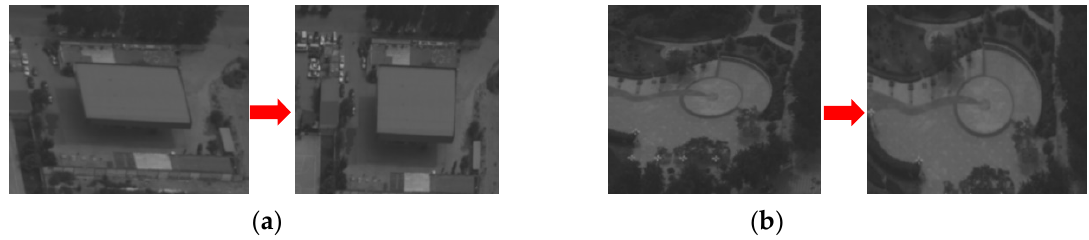
Figure 9. Partial perspective rectification: ( a ) a trapezoid becomes a rectangle after rectification; ( b ) an ellipse becomes a circle after rectification.